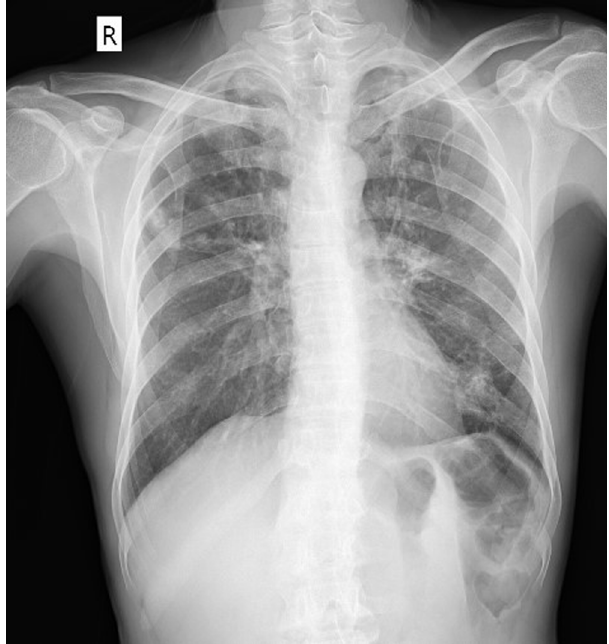
Fig. 4. Chest X ray showing areas of diffuse opaci fi cation.